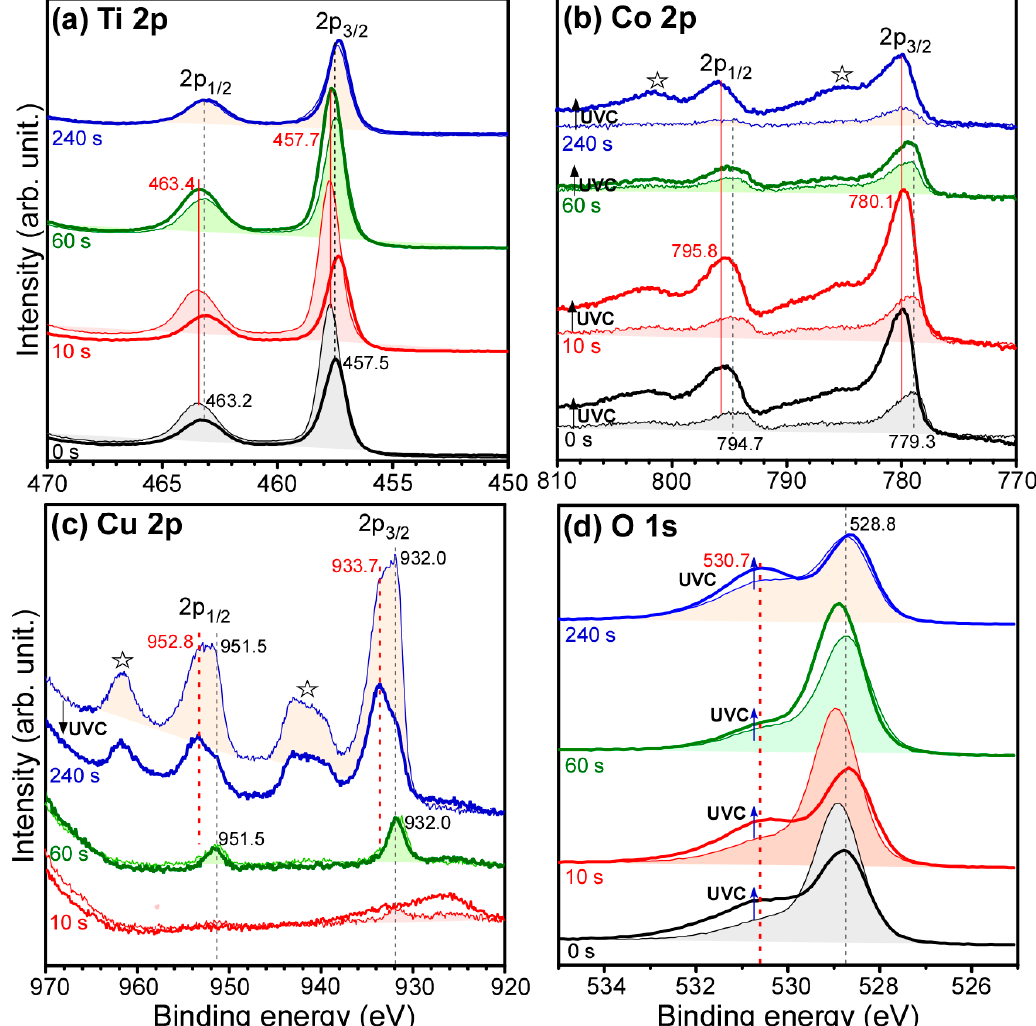
Figure 6. Ti 2p ( a ), Co 2p ( b ), Cu 2p ( c ) and O 1s ( d ) XPS profiles for bare Co-TiO 2 /Ti and 10s, 60 s and 240 s-Cu-deposited Co-TiO 2 /Ti samples before (thin lines) and after (thick lines) UVC photocatalytic reaction. ☆ I ndicates shake-up structures.